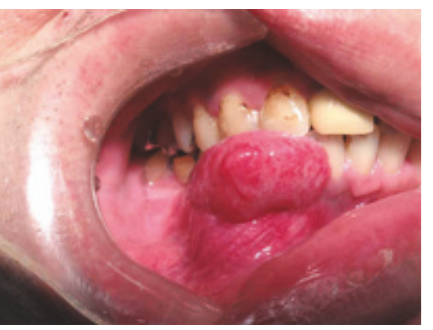
Figure 1: An image of the oral cavity obtained during the initial examination showing a painless mass in the lower right premolar region.